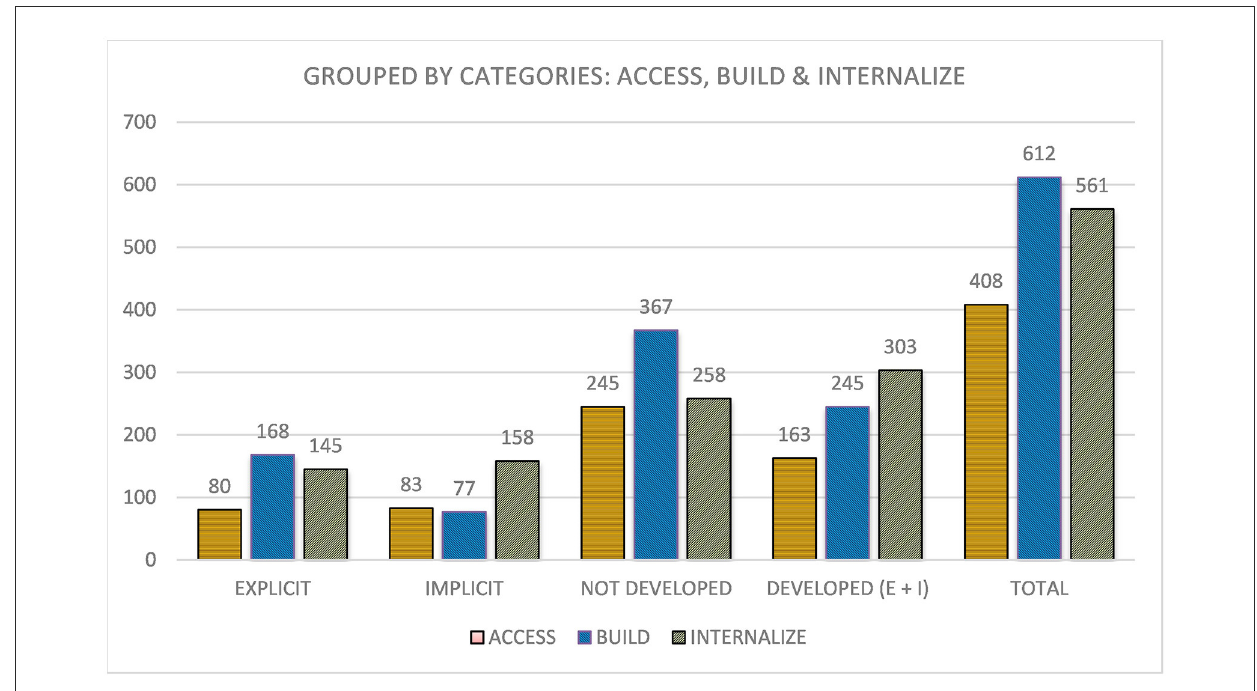
FIGURE5 Identified uses of checkpoints grouped by access, build, and internalize